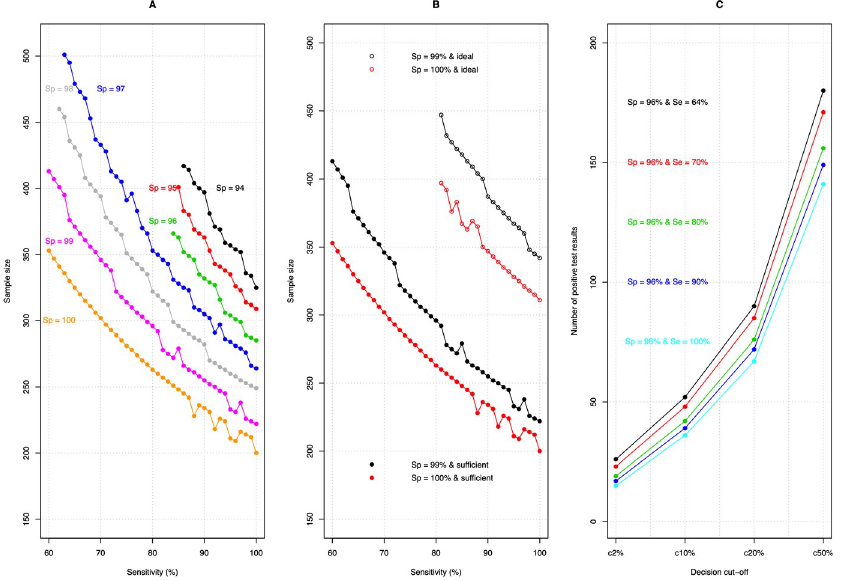
Fig 7. The variation in sample size and decision cut-off for a selection of the diagnostic tests. Panel A describes the variation in sample size across varying sensitivity (60–100%) and specificity (94–100%) when program decision making is adequate. Panel B contrasts the sample size between adequate and ideal program decisions for two diagnostic tests (specificity = 99% and specificity = 100%). Panel C illustrates the variation in decision thresholds (2%- 50%) across four diagnostic tests with the same specificity (96%) but varying sensitivity (64%, 70%, 80% and